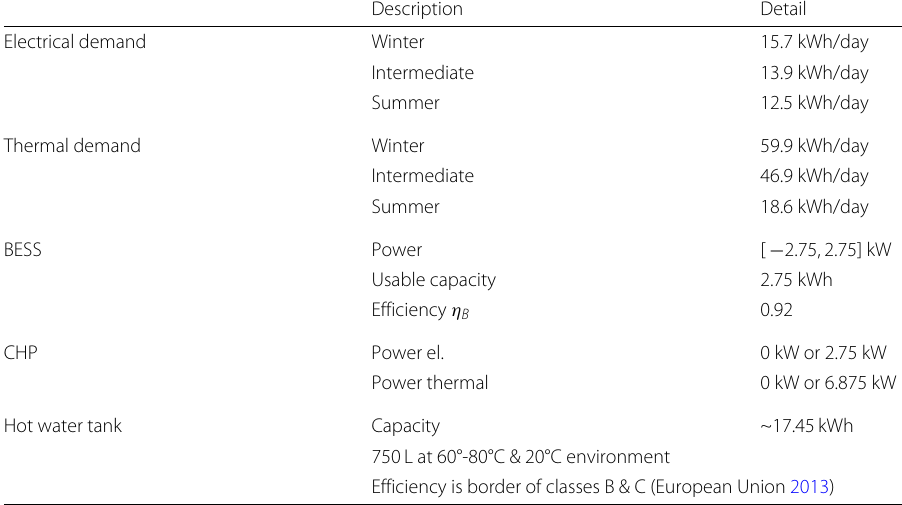
Table 3 Overview of model